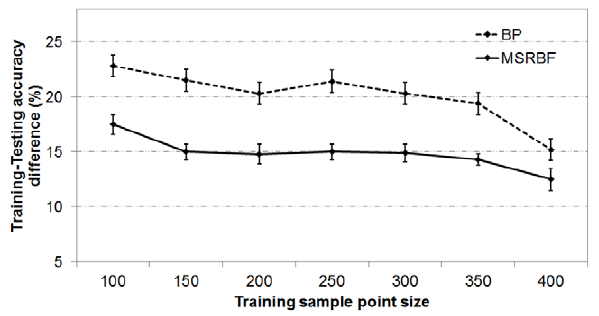
Figure 10. Contrasting MSRBF and MKRBF training progres- sion. Figure 11. Mean and standard deviation on training-testing accuracy